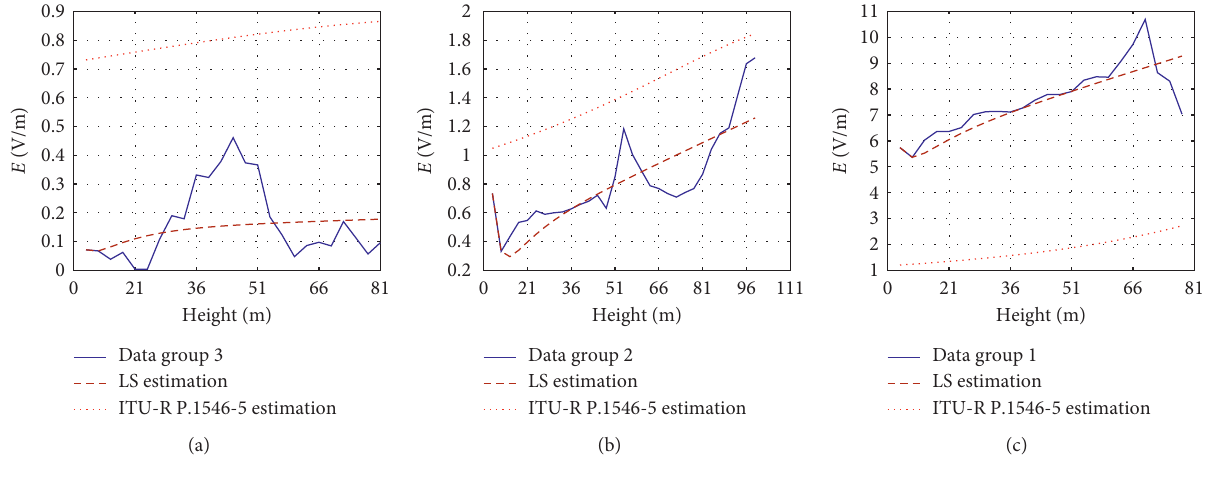
Figure 7: LS estimate for (a) “data3,” (b) “data2,” and (c) “data1.” Table 3: Relative and RMS errors values for LS fitting of original